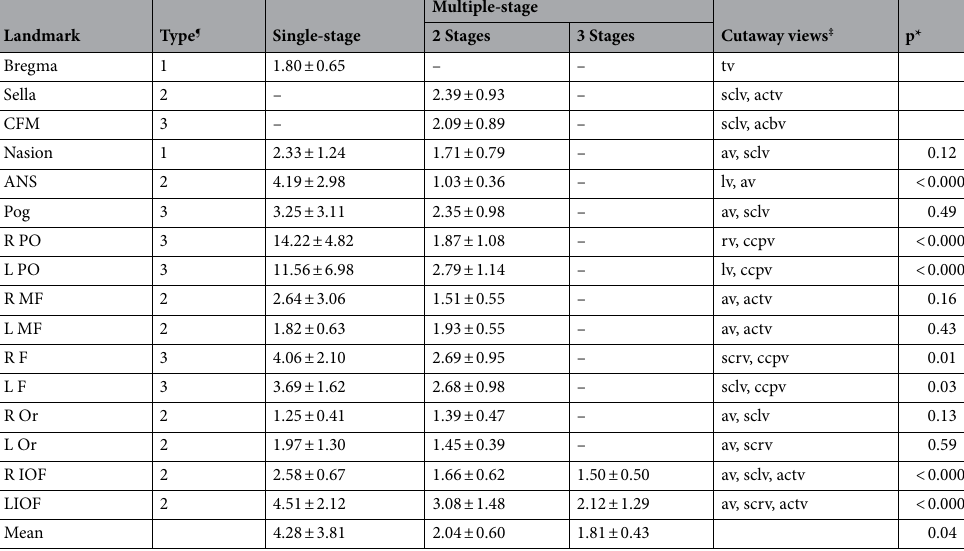
Table 3. Variation of landmark detection error by single- and multiple-staged DRL approach (in 3D distance; mm). ¶Landmark types 1, 2, and 3. Please see detailed descriptions in Supplementary Table 1. ‡ 3D and sectional cutaway views: tv (top view), av (anterior view), rv (right view), lv (left view), scrv (sagittal-cut right view), sclv (sagittal-cut left view), actv (axial-cut top view), acbv (axial-cut bottom view), ccpv (coronal-cut posterior view). * p for 2 stages; by Mann–Whitney test, *p for 3 stages; by Kruskal–Wallis test. p for single- stage vs 2-stage vs. 3-stage; by Kruskal–Wallis test, p =